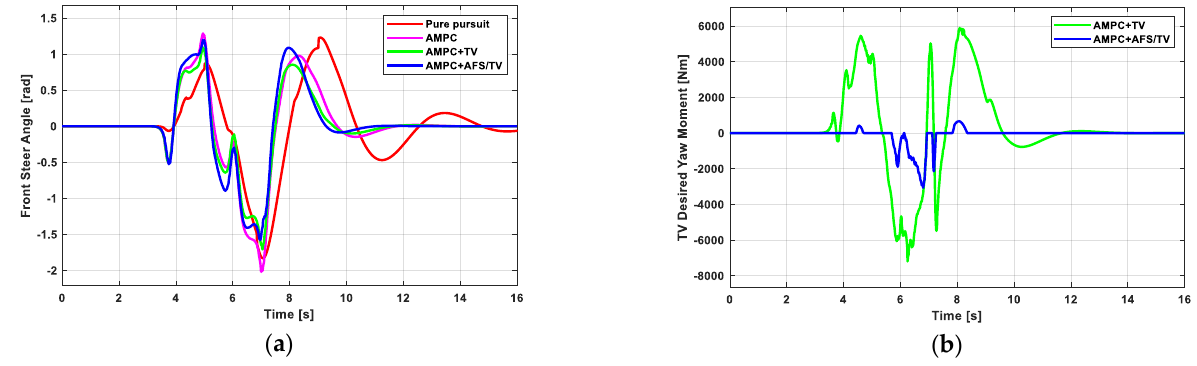
Figure 8. ( a ) Front steer angle and ( b ) desired yaw moment by torque vectoring (TV).